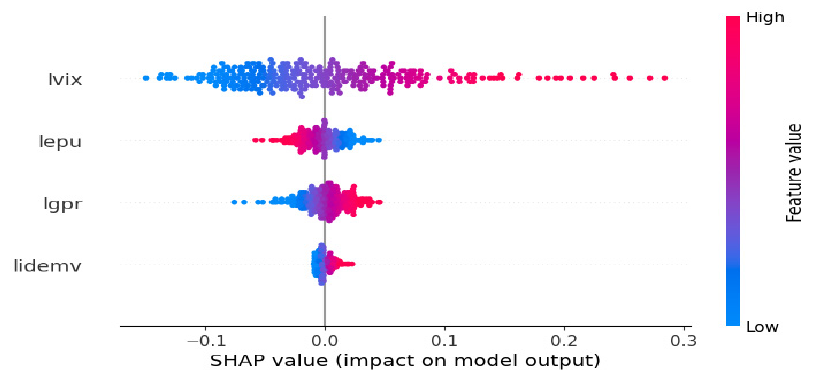
Figure 7. Feature importance before the pandemic—SVM model (Daily frequency).